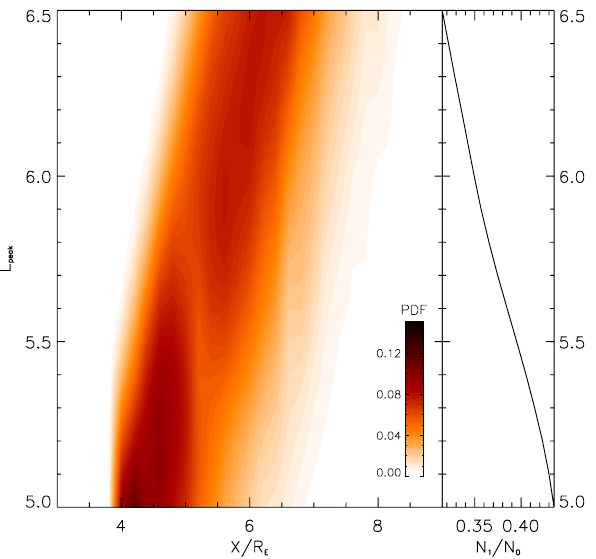
Fig. 2. The reflected wave power of a single chorus element in the equatorial XY plane as a function of radial distance ( x axis), for dif- ferent values of L peak ( y axis). Each distribution (line) is obtained from an initial single chorus element generated at the equator at Y = 0, centered at L peak , and intensity-weighted as in Eq. (1). The value of the distribution in each bin (of 0 . 2 R E width) is shown in the color bar. The ratio of the number of reflected rays (that ef- fectively reach the equator) over the initial number of rays in each single element is shown on the right panel, as a function of L peak